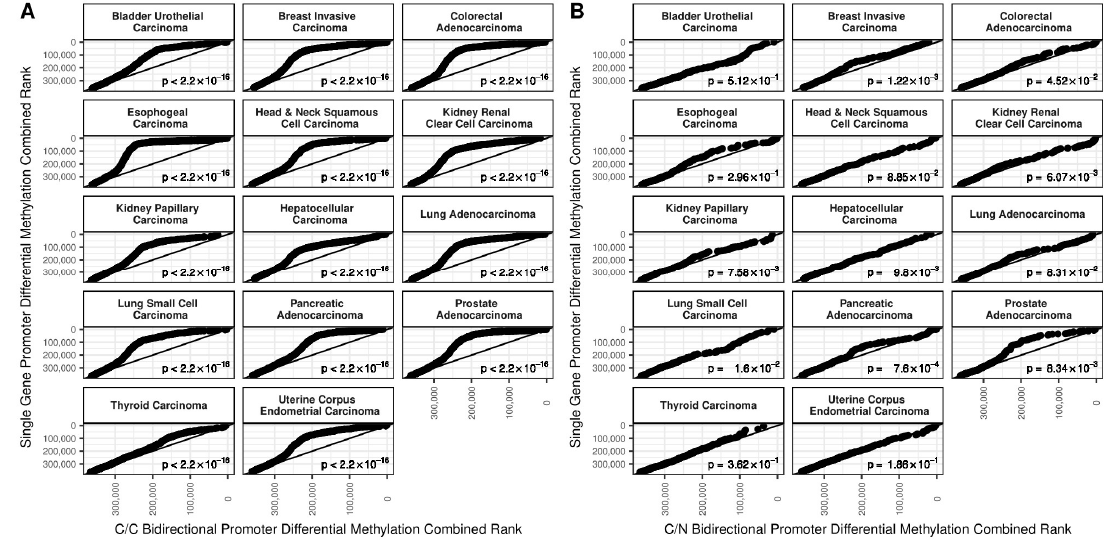
Figure 3. Quantile-quantile plots demonstrating degree of differential methylation in 5003 single gene vs. 657 C/C ( A ) and 97 C/N ( B ) bidirectional promoters restricted to CpG islands. For C/C bidirectional promoters, at every quantile of rank differential methylation, the rank of differential methylation for single gene promoters was always lower (i.e., greater differential methylation). For C/C bidirectional promoters, all results were statistically significant. For C/N bidirectional promoters, this trend mostly continued, but it was much weaker and was not apparent for all cancers.